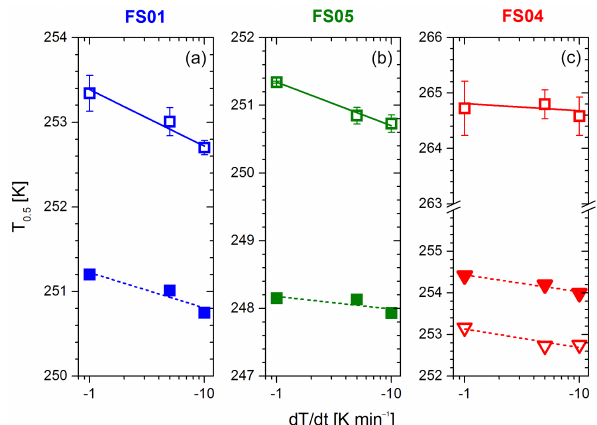
Figure 12. (a, b) Median freezing temperature T 0 . 5 for the aqueous suspensions of FS01 and FS05 aged for over 5 months (blue and green filled symbols). (c) Median freezing temperature T 0 . 5 of FS04 0.8wt% suspension treated with 30% H 2 O 2 for an hour (filled tri- angles) and overnight (open triangles). T 0 . 5 for the freshly prepared suspensions is shown as open square symbols in all three panels. Straight lines are non-weighted linear regressions of the averaged T 0 . 5 values for three different cooling